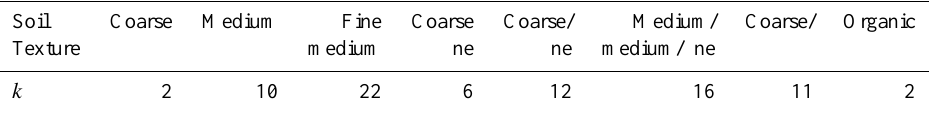
Table 1. Texture-dependent parameter k , which partitions N 2 O / N 2 gas fractions during denitrification, estimated from Del Grosso et al. (2000). Soil Coarse Medium Fine Coarse Coarse/ Medium/ Coarse/ Organic Texture medium fine fine medium/fine k 2 10 22 6 12 16 11